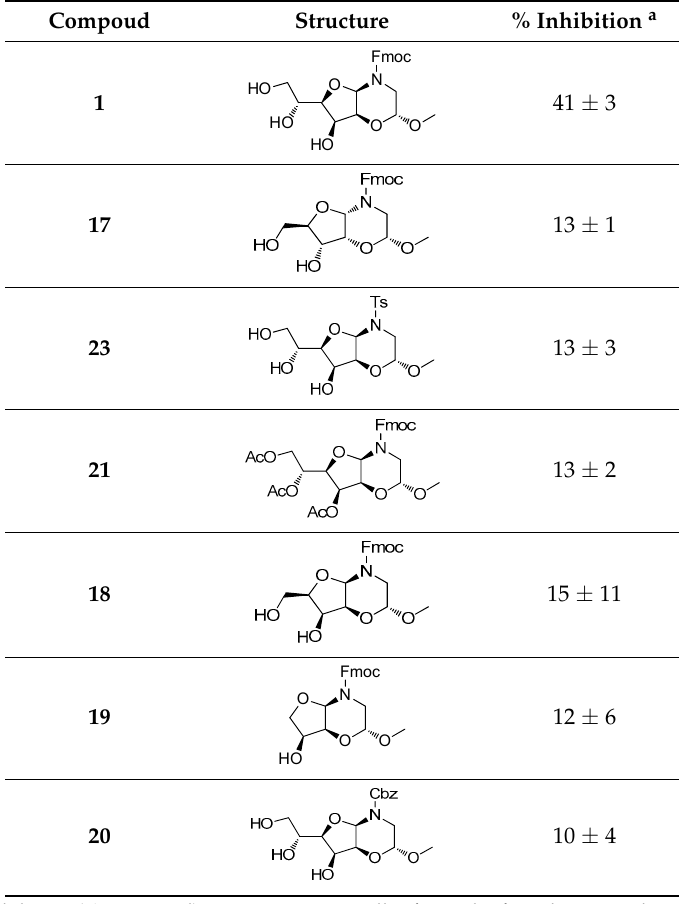
Table 2. Cell growth inhibition of MDA-MB-231 cell line at 10 µ M concentration after 48 h of incubation. Cmpd